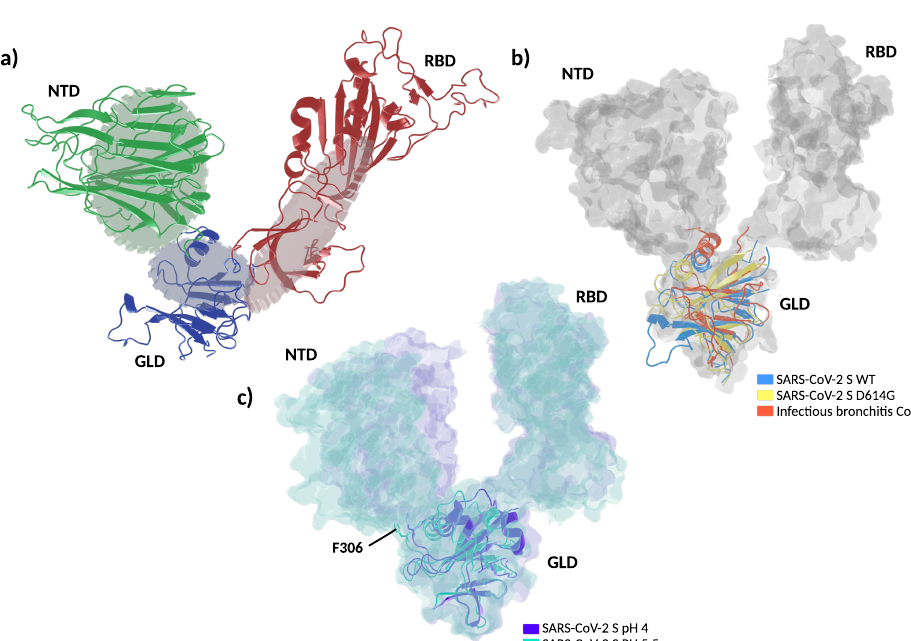
Figure 5. Proposed molecular dynamic of spike protein. ( a ) Schematic representation depicts a proposed gear-like mechanism for the molecular dynamic of the S1 subunit in which the rotation of gear-like domain (GLD) is accompanied by the solidary movement of the N-terminal and receptor binding domains (NTD and RBD respectively). ( b ) Superposition of spike experimental structures in the all-RBD-down state captured with different rotations of the GLD, depicting a counter-clockwise rotation of the gear-like domain. The GLD is shown in cartoon representation and NTD and RBD from the wild type protein are shown in solvent accessible surface. In blue: SARS-CoV-2 S wild type (WT) (pdb: 6XR8), yellow: SARS-CoV-2 S D614G (pdb: 6XS6), red: infectious bronchitis coronavirus (pdb: 6CV0). ( c ) Superposition of spike experimental structures in the all-RBD-down, depicting domain movements between pH 5.5 and 4.0. In purple: spike at pH 4.0 (pdb: 6XLU), calypso: spike at pH 5.5 (pdb: 6XM5). F306 are shown as sticks. NTD: N-terminal domain, RBD: receptor binding domain, GLD: gear-like